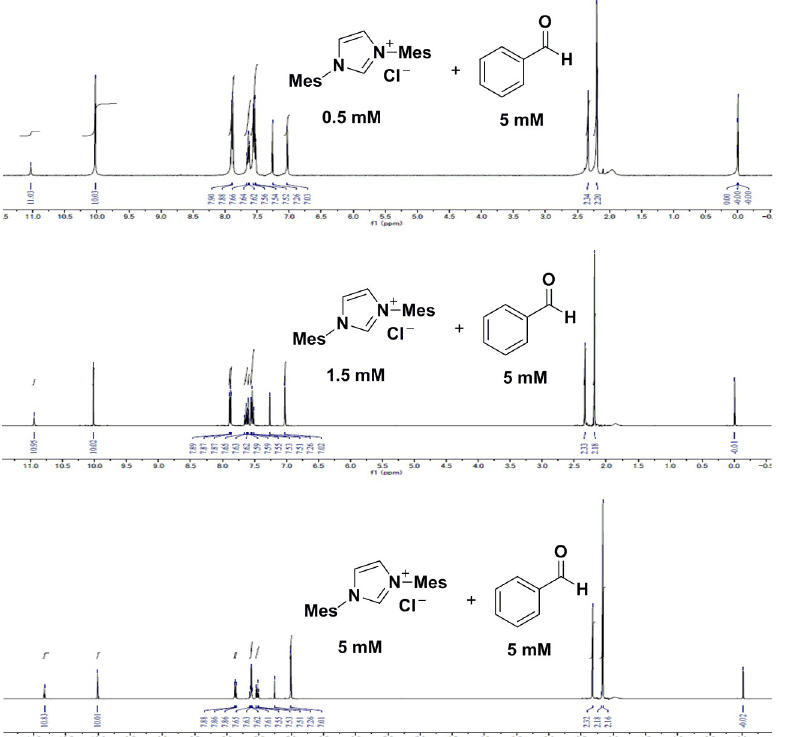
Fig 7. 1 H-NMR investigation of the interaction of IMesCl (1a) and benzaldehyde (3) in CDCl 3